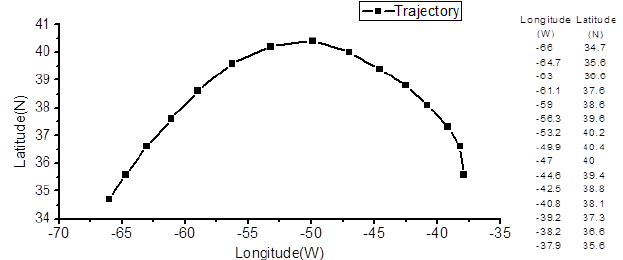
Fig. 3. An original path of a moving object.